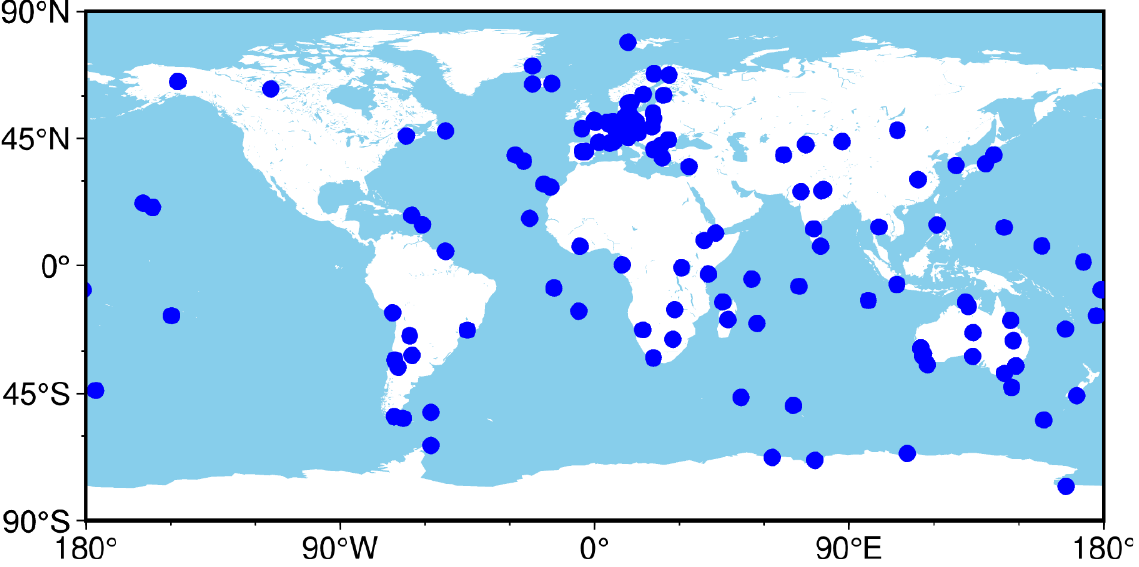
Table 1. Processing strategy for system combination PPP.